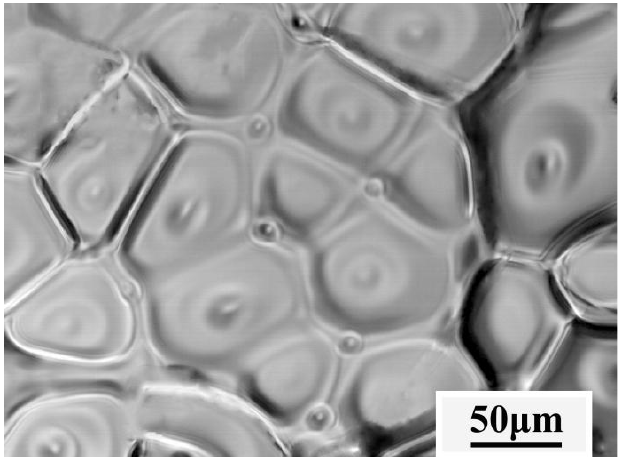
Figure 4. The final solidified microstructure of the Ce ‐ HMASS sample under the cooling rate of 50 °C /min obtained from HT ‐ CLSM.